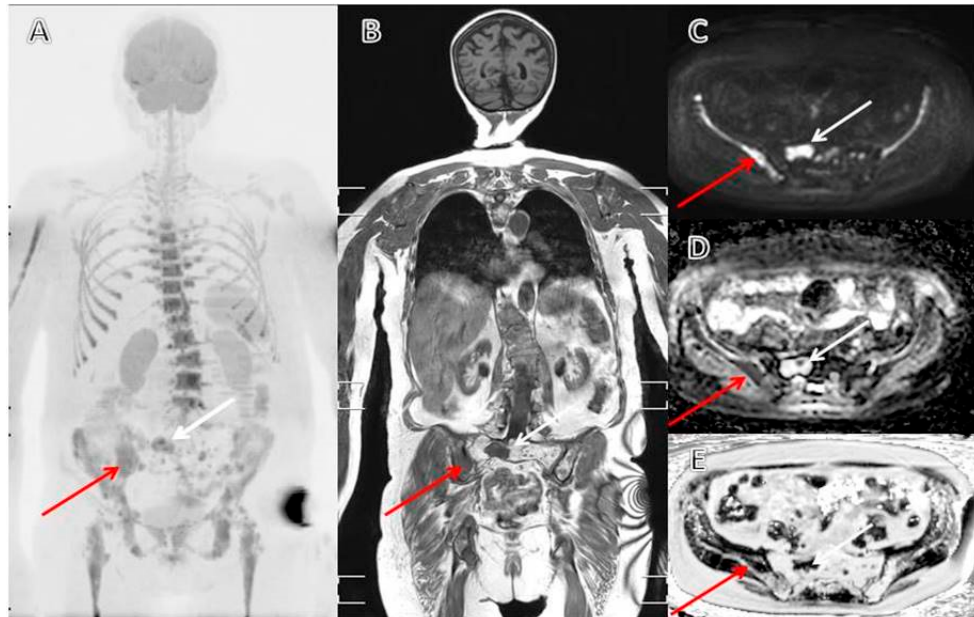
Figure 3. Whole body MRI of relapsing Myeloma, multiple new lesions primarily in right arm, spine, ribs and right side of pelvis. Many previously treated lesions in spine, pelvis and legs. Red arrow: typical new lesion with myeloma cells (low, homogenous ADC), White arrow: typical old lesion with cell free water content (high ADC) and possible focal recurrence. ( A ) MIP of DWI-sequence with high b-value, ( B ) T1-DIXON in-phase sequence, ( C ) DWI-sequence high b-value, ( D ) ADC (parametric map calculated from DWI), and ( E ) Fat fraction (parametric map calculated from